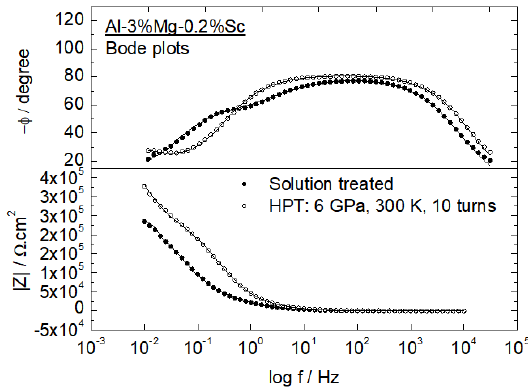
Figure 6. Bode diagrams of impedance modulus and phase angle versus frequency of solution treated and HPT-processed alloy